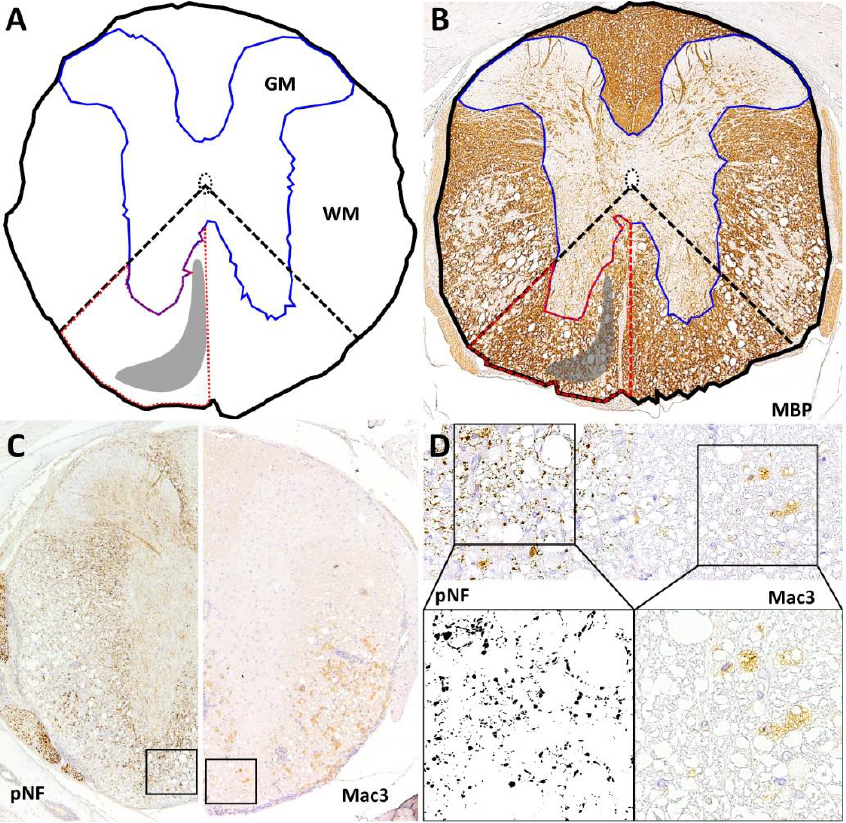
Figure 7. Quantification of cross-sectional area (CSA; black line), white matter (WM), gray matter (GM; blue line) and the approximated area of the rostral reticulospinal tract (rrts; red dashed line) using MBP-stained sections. Localization of rrts is marked as gray area. Area of rrts was approximated via an angle bisector (dashed line) between a vertical and horizontal line intersecting at the central canal (matrix: A ; application example: B ) For assessment of axonal loss and inflammation, images from the rrts were taken at high magnification (40× objective). One picture was taken from the left and right ventromedial white matter each, saved as tiff file ( C ) and a counting frame (120 μm × 120 μm) was inserted ( D ). For quantification of axonal density, images were converted to 8bit grayscale ( D ). After an adjustment of threshold axons were counted and separated in small (1 – <4 μm²) and large axons (≥4 μm²) via adjustment of size of the detected particles. Axonal density was calculated as pNF + particles per mm². Mac3 + cells within the counting frame were counted manually and calculated as Mac3 + cells per mm² ( D ).